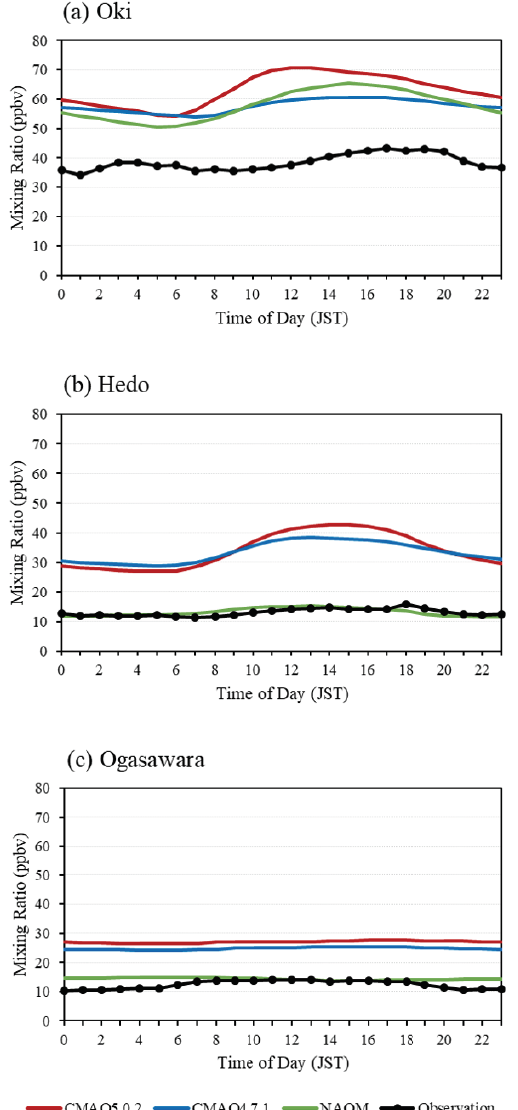
Figure 2. Comparison of monthly averaged diurnal variation of O 3 at (a) Oki, (b) Hedo, and (c) Ogasawara in July 2010 between ob- servation and model simulation by CMAQ v.5.0.2 and 4.7.1 and NAQM v.3.